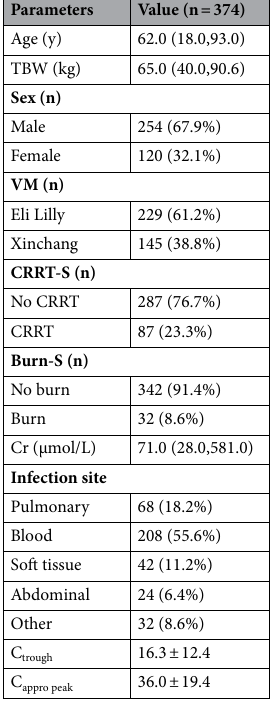
Table 1. Summary of patient